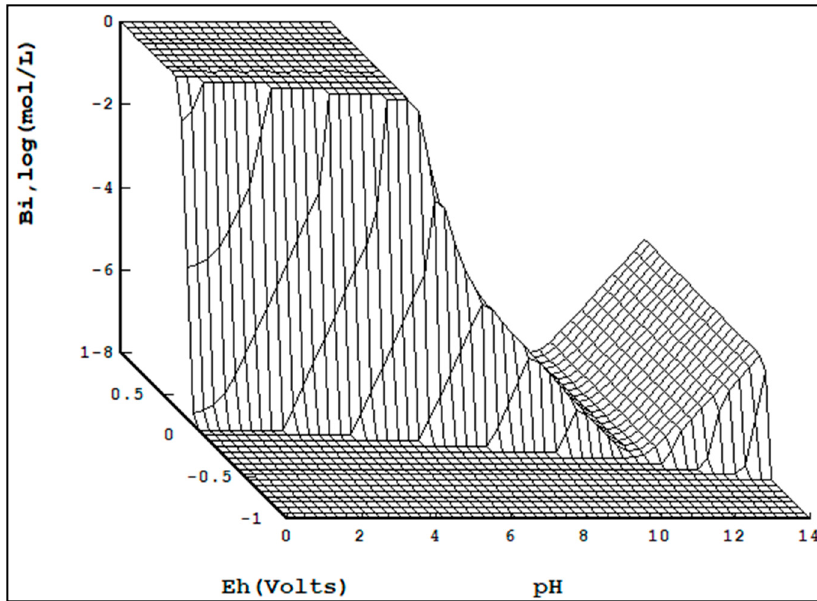
Figure 4. 3D Bi Pourbaix diagram.